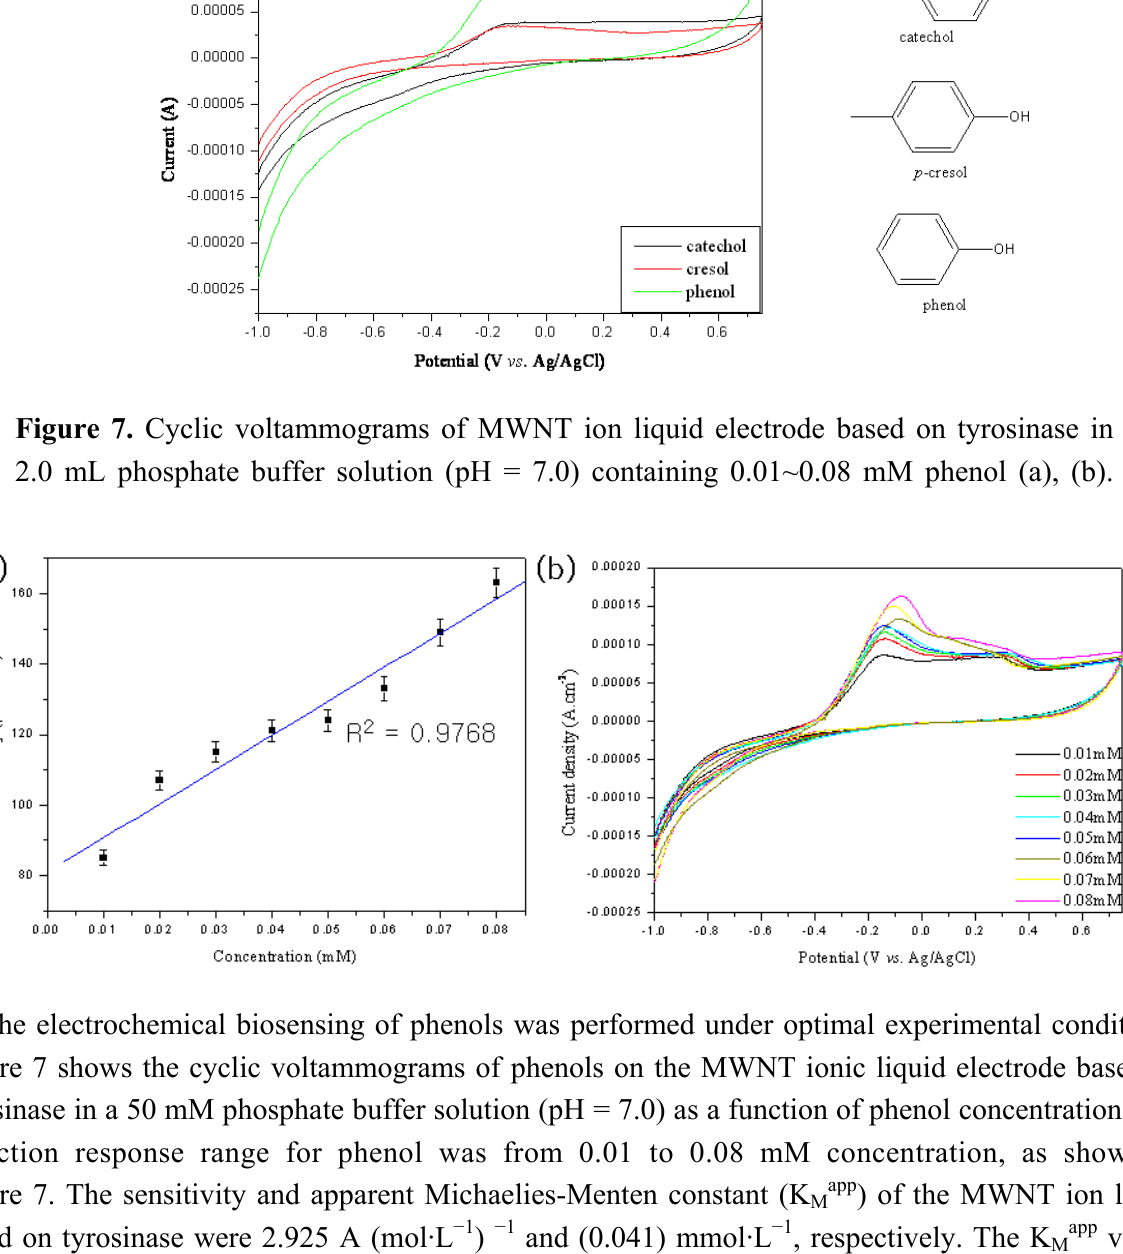
Figure 7. The sensitivity and apparent Michaelies-Menten constant (K based on tyrosinase were 2.925 A (mol·L − 1 ) − 1 and (0.041) mmol·L − 1 , respectively. The K Mapp